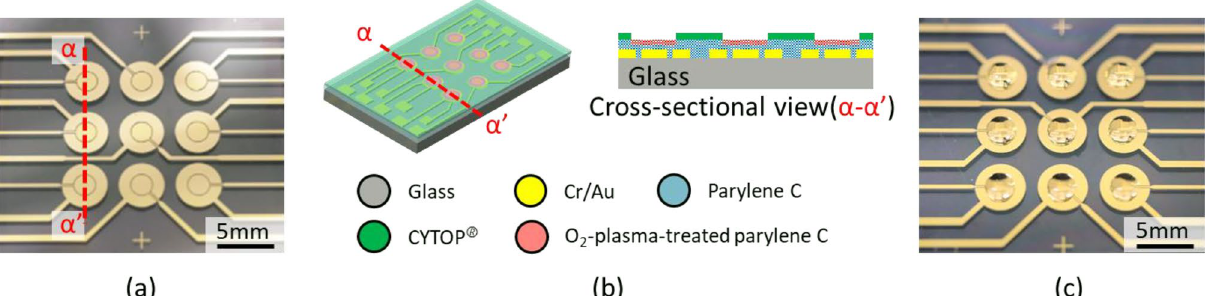
Figure 4. Fabrication result of the device for height control of droplets by EWOD technology. ( a ) Top view of fabricated device with three by three arrays of circular patterns. Each circular pattern for a droplet has center and outer electrodes under the hydrophilic–hydrophobic pattern. The diameters of the hydrophilic– hydrophobic pattern and outer electrode are 2.48 mm and 4 mm, respectively. An initial hemispherical droplet on the 2.48 mm diameter circular pattern of the hydrophilic–hydrophobic surface has a 4 μl volume with a 90° contact angle. The diameter of the center electrode is 1.86 mm, and the gap between the center and outer electrodes is 70 µm. ( b ) Schematic and cross-sectional drawings of the device. A cross-section of red dotted lines in ( a ) and a schematic drawing are shown. Cr (70 nm thick)/Au (200 nm thick) electrodes are patterned on a glass substrate and coated and insulated by 1 μm-thick-parylene C. The parylene C is partially treated by O 2 plasma to obtain a hydrophilic surface. 12 nm-thick-Cytop ® , a hydrophobic material, is patterned to define the circular pattern of hydrophilic parylene C treated by O 2 plasma for droplet generation. ( c ) Three by three arrays of DI water droplets are prepared on the